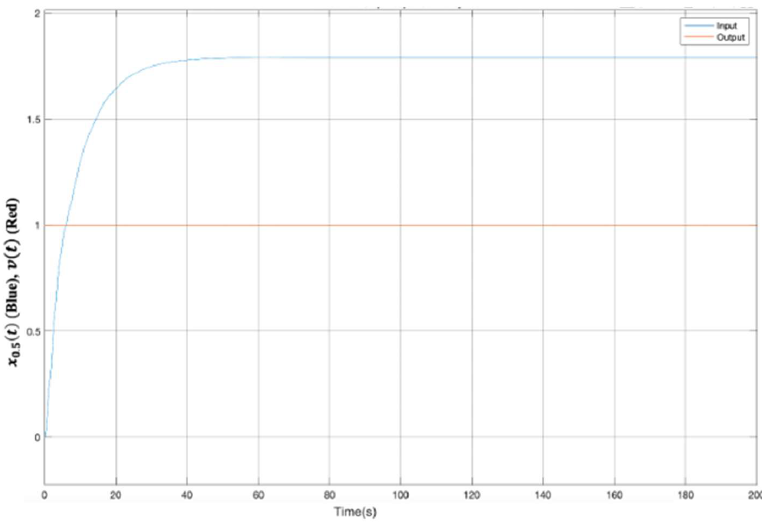
Figure 5. Response to a Step Input in the 𝒑 -plane.